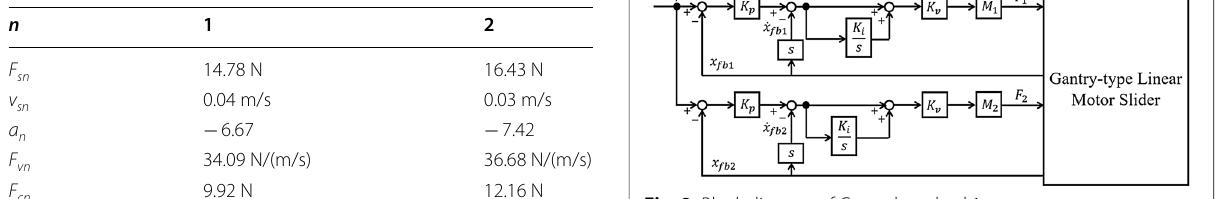
Fig. 8 Block diagram of Control method